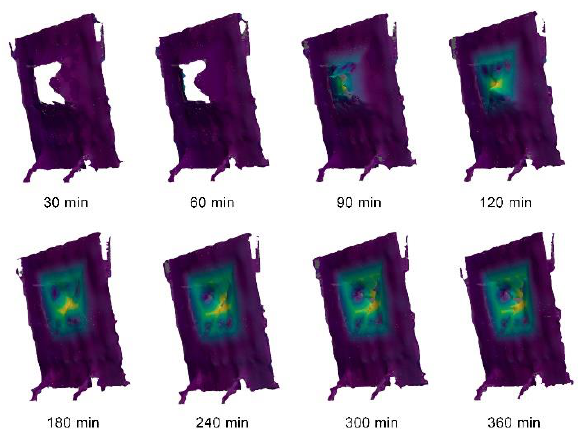
Figure 3 . The LCDC acquisitions show the meshes with the coloured map corresponding to the different displacements.